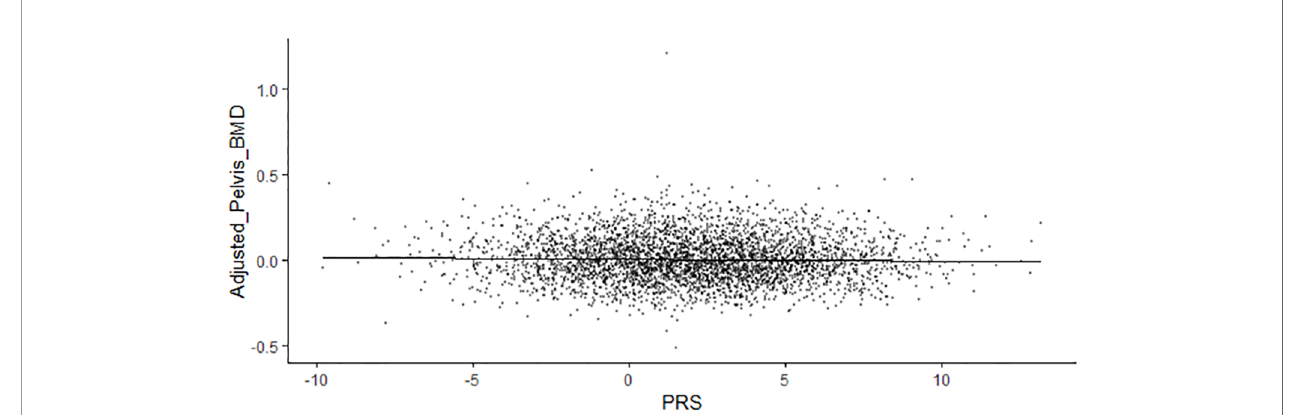
FIGURE 1 | The scatter plot of the adjusted pelvis BMD and gut microbiota PRS.